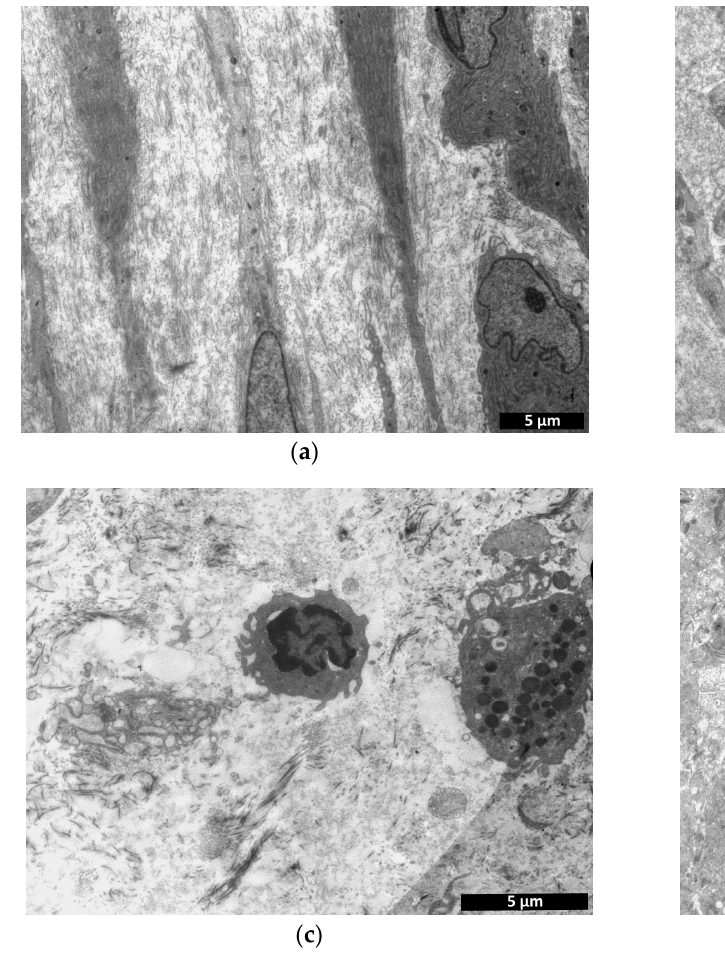
Figure 16. Comparison of experimental material—cell-containing scaffolds ( a , c ) and controls—cell- containing collagen matrices ( b , d ): transmission microscopy, day 14. ( a , b )—cells of fibroblastic origin; ( c )—lymphocyte and macrophage; ( d )—lymphocytes and fibroblasts.